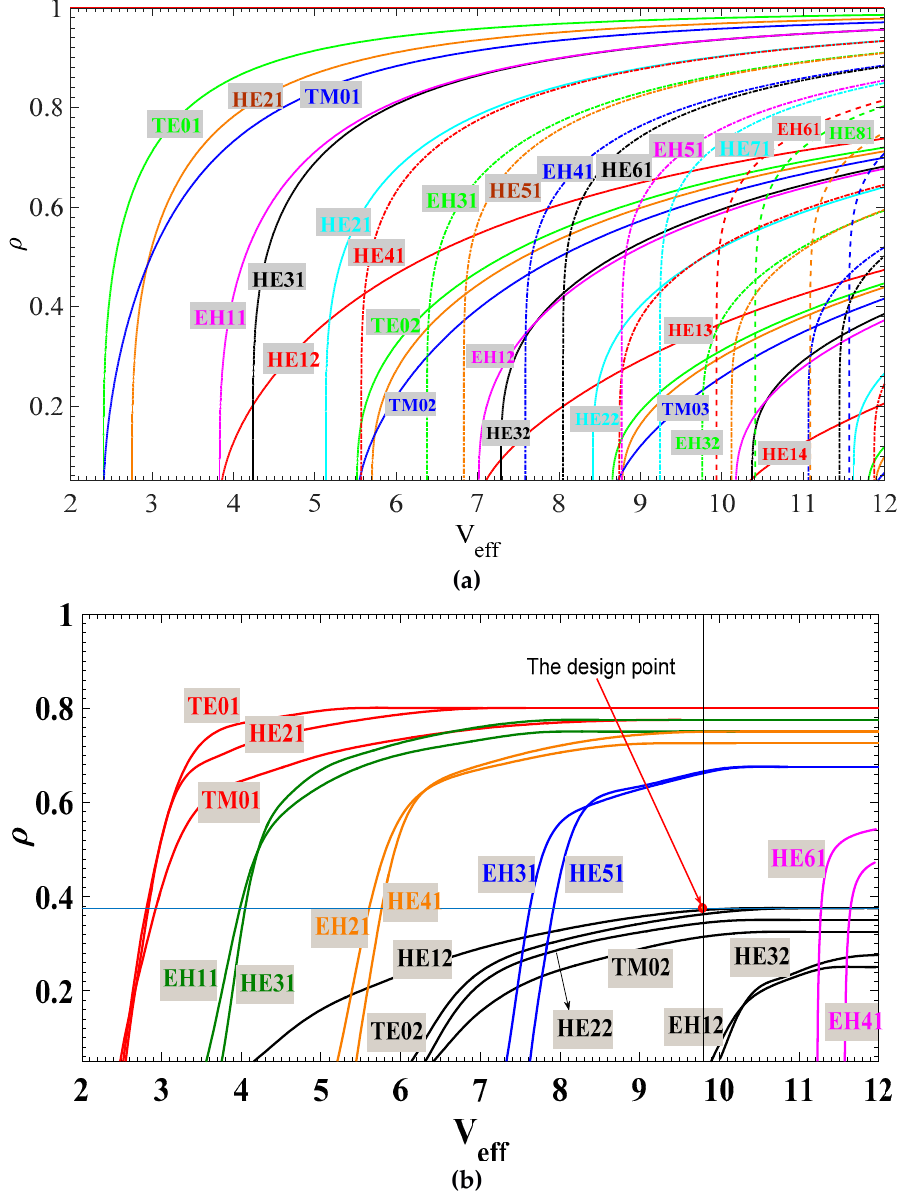
Figure 5. ( a ) Modal map of the ring core fiber; ( b ) modal map of the C-PCF corresponding to removing off the first one air-hole ring (the C-PCF 1#).